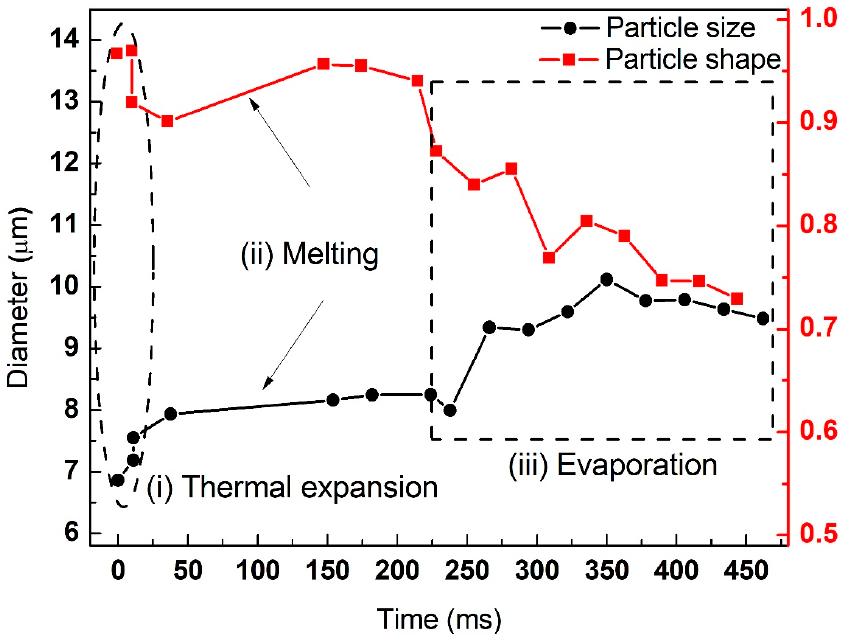
Figure 8. The variation of particle diameter and circularity of individual aluminum particles (initial diameter of 6.67 µ m, laser power density of 7.56 × 10 5 W / cm 2 ).